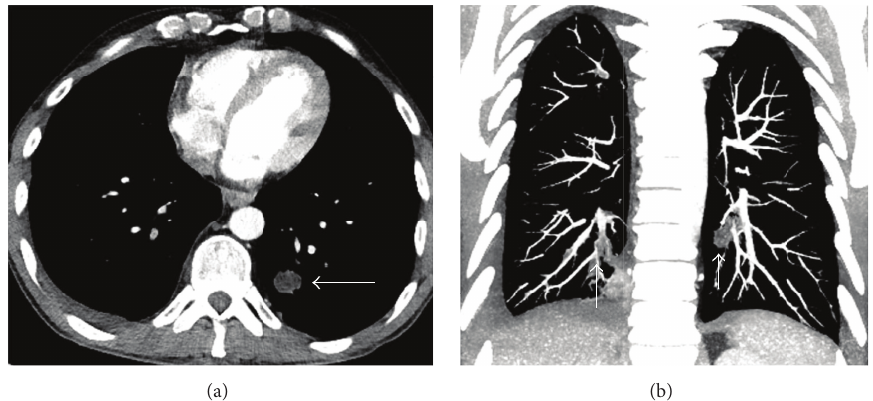
Figure 2: Axial contrast-enhanced CT scan (a) and coronal MIP image (b) show multiple cystic nodules in the inferior pulmonary arteries (arrows).